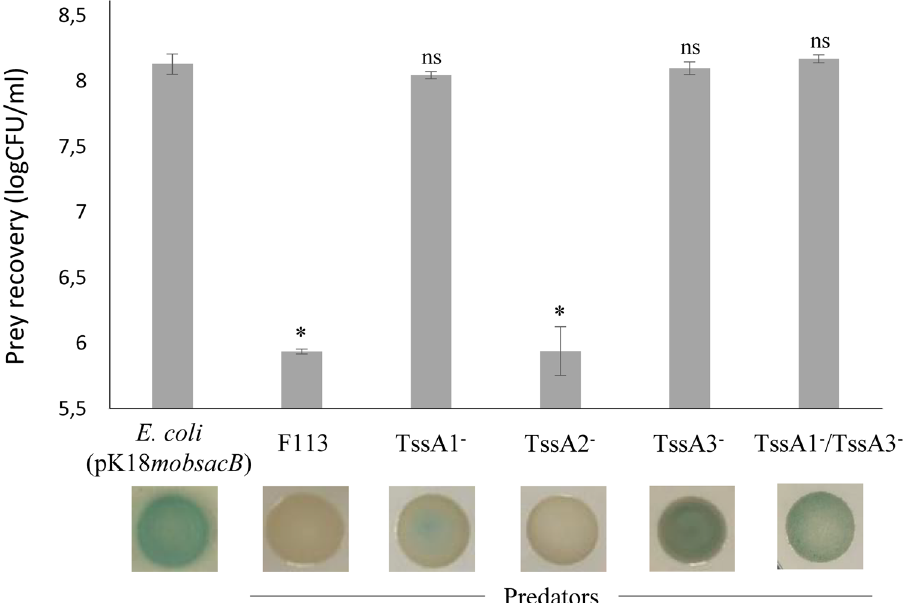
Figure 5. Bacterial killing ability of the three T6SSs of P. fluorescens F113. Interbacterial Competition Assay of P. fluorescens F113 and T6SS mutants, against an E. coli strain carrying pK18 mobsacB expressing lacZ . The bars indicated the amount of prey recovery from each attacker expressed as logCFU/ml. Bottom row shows the E. coli growth for each competition experiment. Blue colour in bacterial patches on LB plates supplemented with X-gal and kanamycin indicates E. coli growth. Error bars indicate the mean ± s.d. of three biological replicates, and significance was calculated using ANOVA test (* P < 0.01); ns, not significant differences when compared to non-competing E. coli